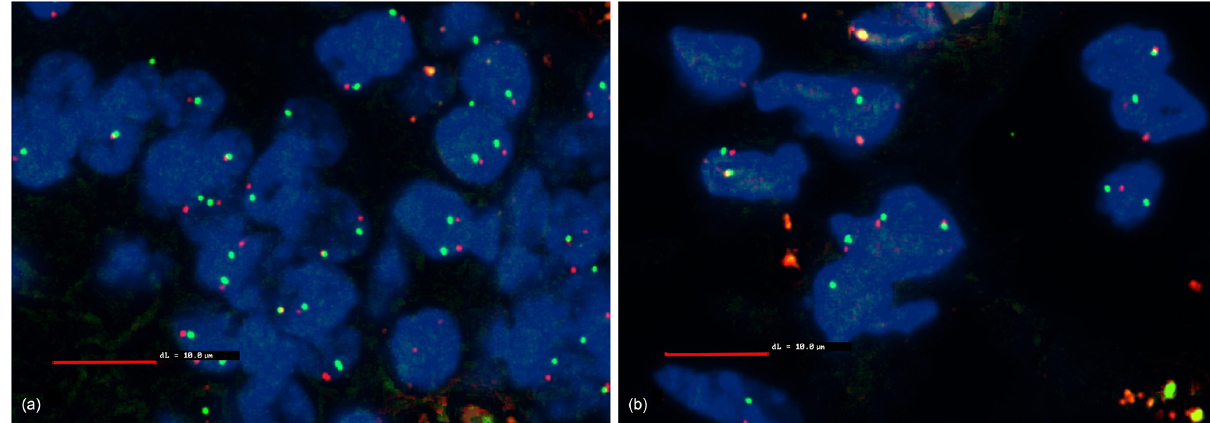
Figure 6. Fluorescence in situ hybridization (FISH) with MTAP (scale bar: 10µm). Blue: DAPI staining of the cell nucleus. Red: Texas- red-stained MTAP probe. Green: FITC-stained CEN9q locus as control. Non-hyperplastic cells serve as a control. The CEN9q locus (green) localized close to the gene of interest (red) serves as a positive control to detect the chromosome pair. In a healthy cell, each nucleus should show two red and to green signals with a red and a green signal close together. If a deletion is present in a cell, only a single green signal of the CEN9q locus is visible. Some nucleoli might be cut between or even within chromosomes; therefore, a threshold of 10% is defined for diagnosis of a deletion. No deletion detectable. (a) Non-hyperplastic cells of the jejunum; (b) mesothelial hyperplastic cells of the